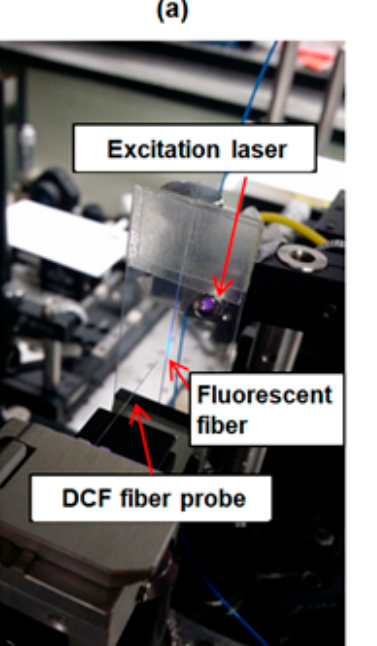
( b ) Figure 6. ( a ) Fluorescence emission spectrum of the water-soluble fluorescent solution; the first small peak indicates the wavelength of the fluorescence excitation laser source (405 nm), and the second peak presents the emission spectrum. ( b )